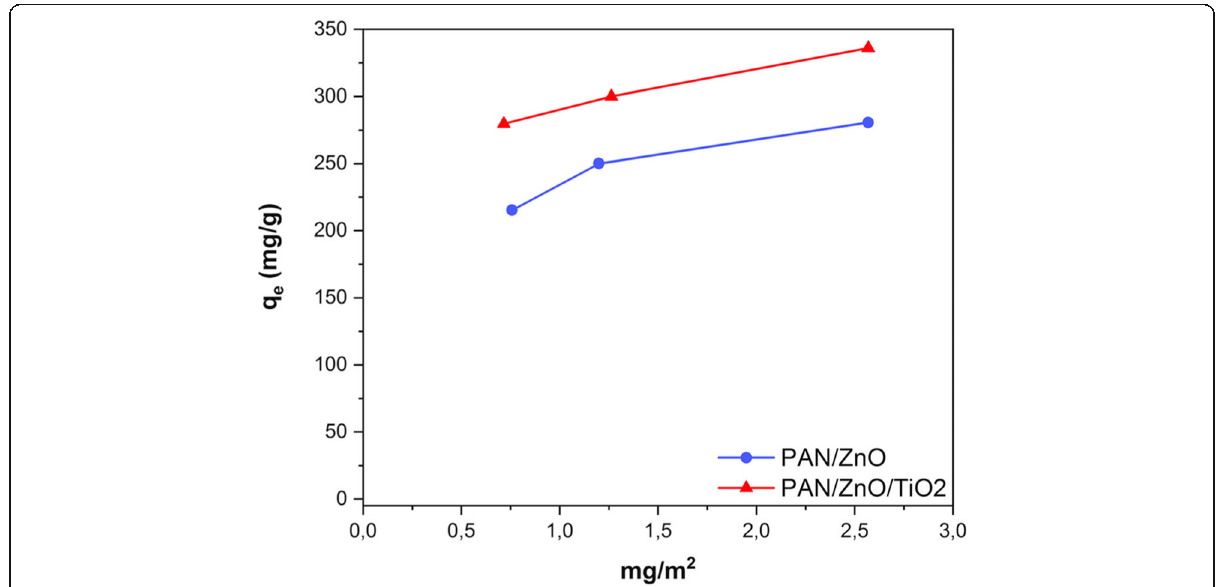
Fig. 5 Effect of n- fib@Mat surface area on the adsorption of Cr